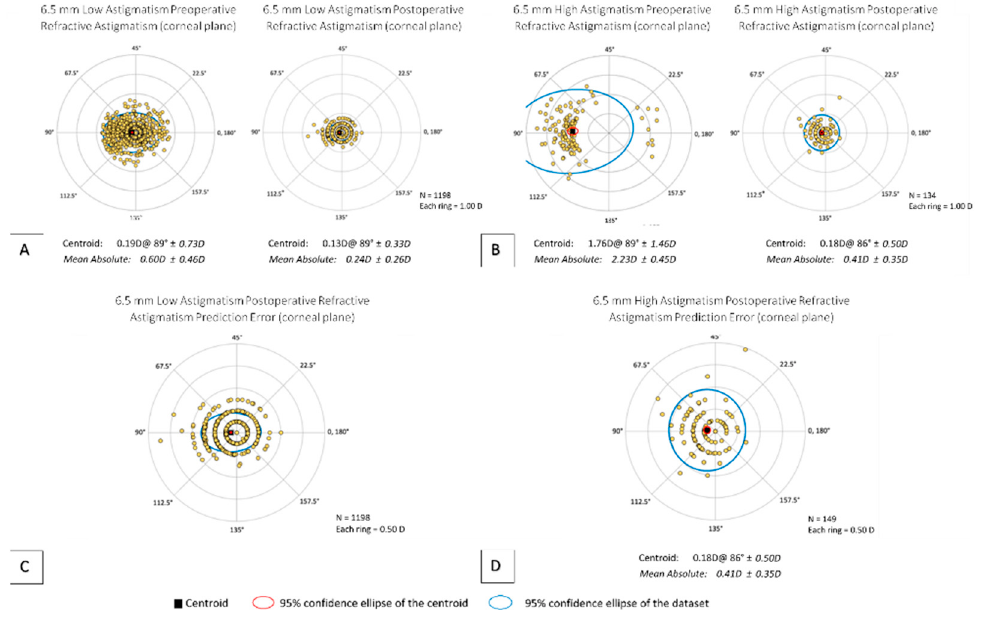
Figure 4. Vector analysis of 6.5 mm Low and High Astigmatism Subgroups. ( A ) Comparison of preoperative and postoperative refractive astigmatism for 6.5 mm Low Astigmatism; ( B ) comparison of preoperative and postoperative refractive astigmatism for 6.5 mm High Astigmatism; ( C ) postoperative refractive astigmatism prediction error for 6.5 mm Low Astigmatism; ( D ) postoperative refractive astigmatism prediction error for 6.5 mm High Astigmatism.